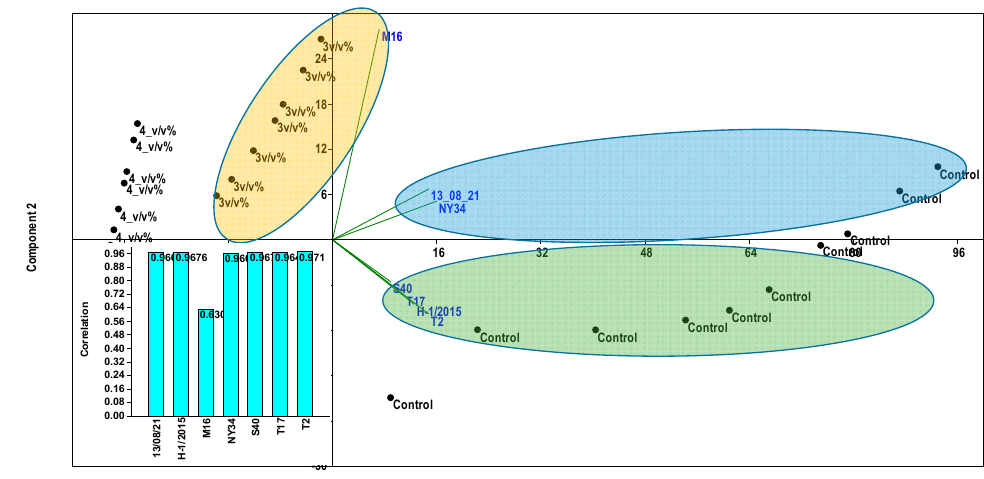
Figure 2. Principal Components Analyses (PCAs) showing the e ff ects of 3 and 4 v / v % populin treatments or their absence (control) on the colony growth of di ff erent late blight strains under lab conditions. The average strain-dimension data in plates after 3 and 4 v / v % and the controls were considered and log10 transformed. Correlations between PCA values are given in bar charts. The blue and green colors represent the PCA axis direction of the control e ff ect related to sensible stains. Yellow represents the PCA axis direction of the populin 3 and 4 v / v % concentrations e ff ects.